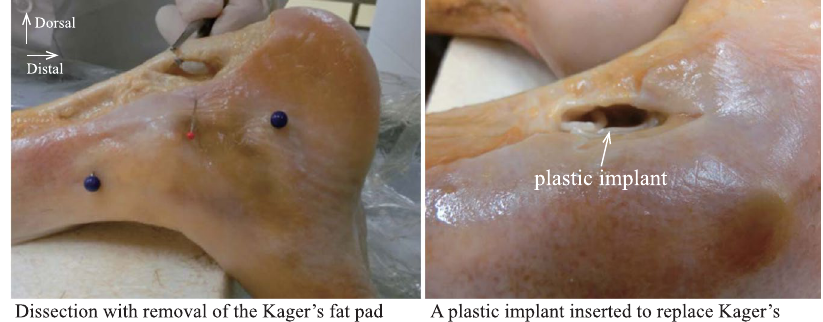
Figure 6. Examples of dissection with removal of the Kager’s fat pad (right) and implantation of a plastic material into the Kager’s fat pad (left). The right image (medial view of a right lower leg) and left image (lateral view of a right lower leg) were obtained after removal of the Kager’s fat pad and after a plastic implant was inserted to replace Kager’s fat pad,